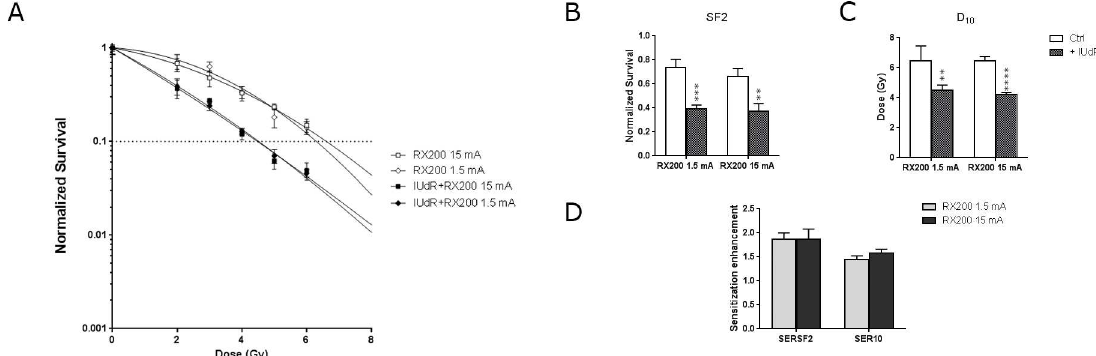
Fig 1. Impact of doserate on IUdR radiosensitization. (A) Cell survival assays obtainedwith F98 cells incubatedin presence or in absenceof IUdR before irradiationwith RX20015 mA or RX2001.5 mA beam. (B) Surviving fractions at 2Gy (SF2), (C) doses giving10% of cell survival (D 10 ) and (D) sensitization enhancement ratios (SER) were determined(n (cid:21) 3). Completelists of SF2, D10 and SERs values are availablein S1 SupportingInformation as Table D and Table E. A polychromatic low-energy X-ray source is sufficient to enhanceIUdR